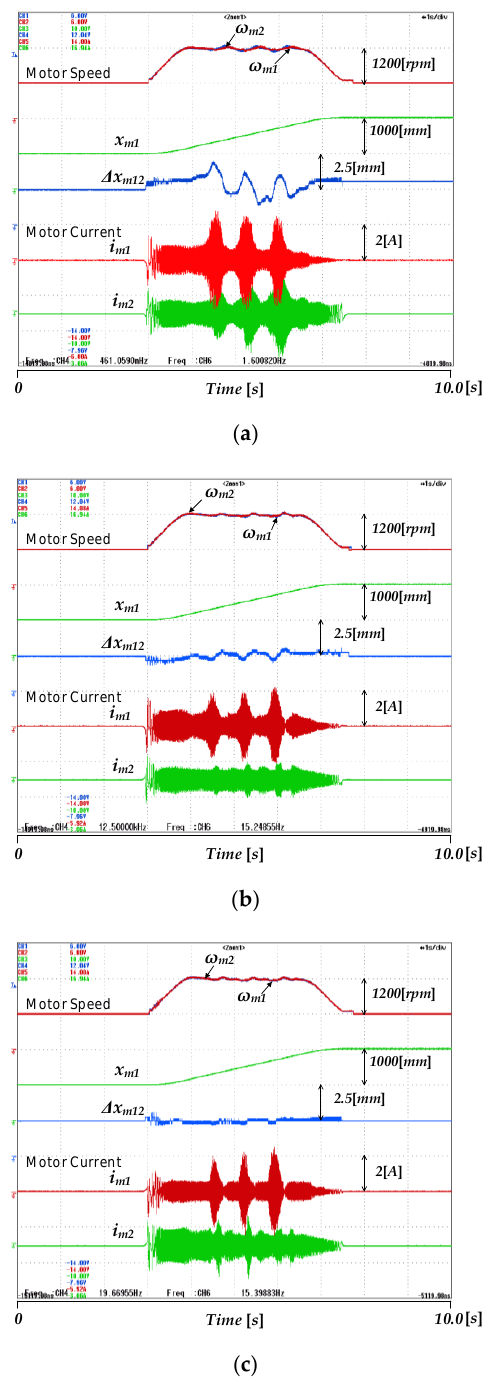
Figure 14. Experimental result of 10N repetitive load on the left motor: ( a ) conventional position control method; ( b ) balancing position control method; ( c ) proposed control